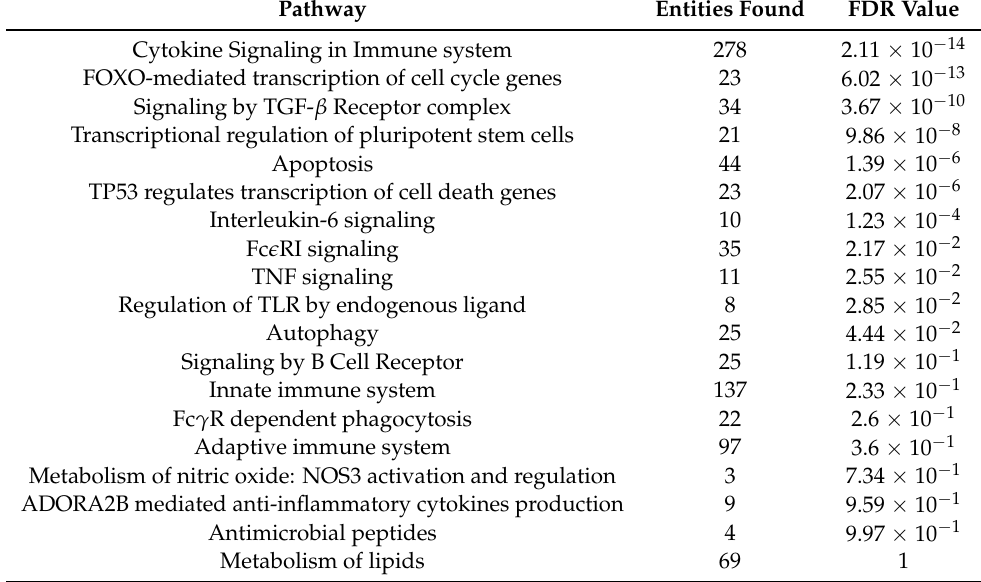
Table 2. Gene set enrichment analysis results for genes associated with downregulated miRNAs (Medical Samples vs. External